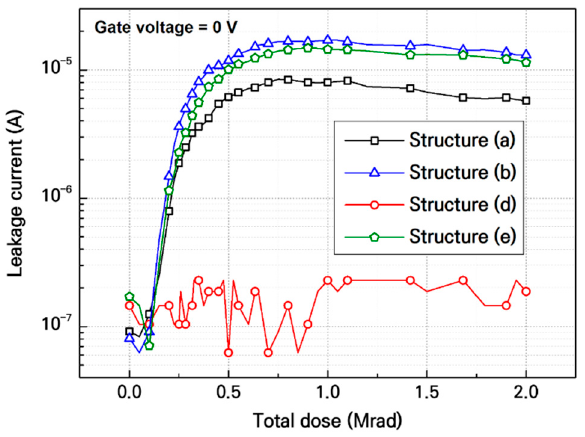
Figure 6. Leakage current with respect to the cumulative radiation dose for each modified n-MOSFET layout structure.